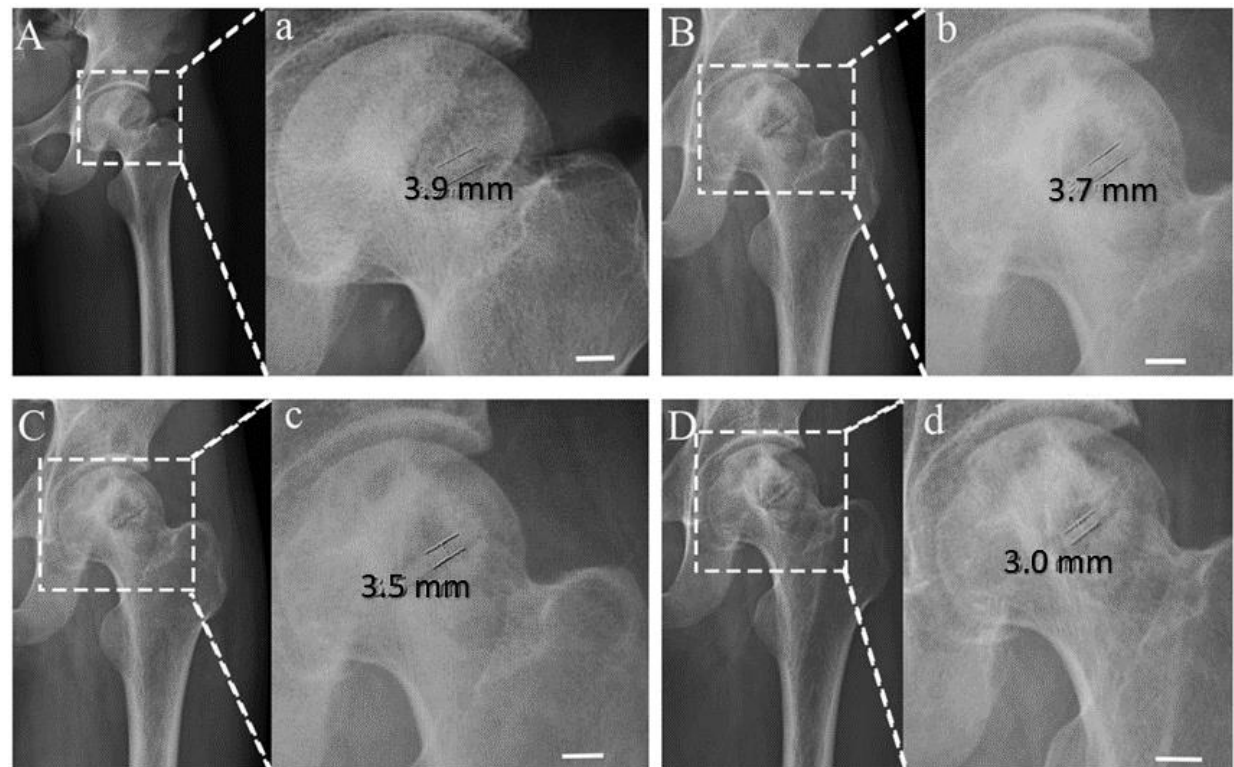
Figure 3. The temporal changes in biodegradation rate of Mg screws interpreted by a decrease in screw diameter. ( A – D ) X-ray imaging of femoral head in patients implemented with Mg screws at 1 ( A ), 3 ( B ), 6 ( C ), and 12 ( D ) months postoperatively. ( a – d ) Magnified surgical regions in ( A – D ) for measurement of screw diameter at different time points. Scale bar represents 10 mm. [74].